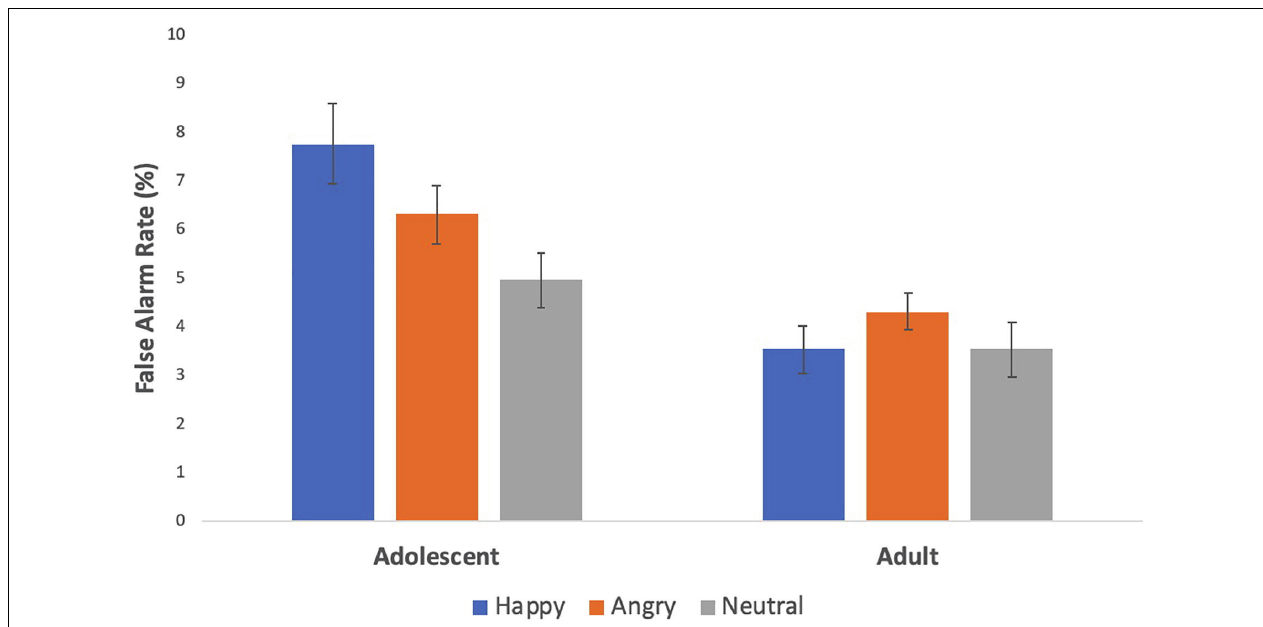
FIGURE 2 | Behavioral effects on the social stop signal task. Adolescents had greater inhibitory failures to social reward and threat cues than to neutral cues, and more so to social reward than threat